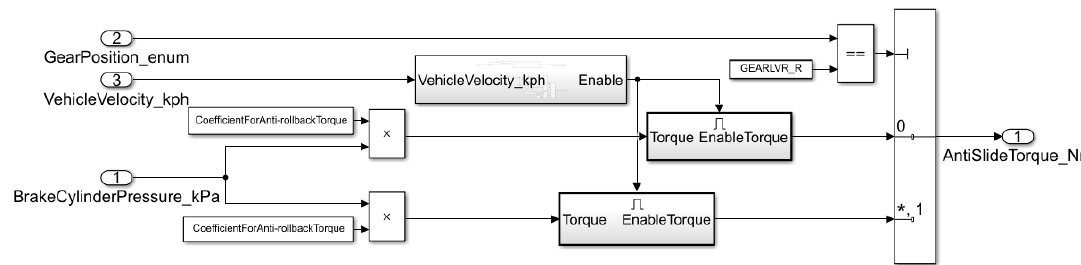
Figure 8. Anti-rollback Torque Calculation Module.